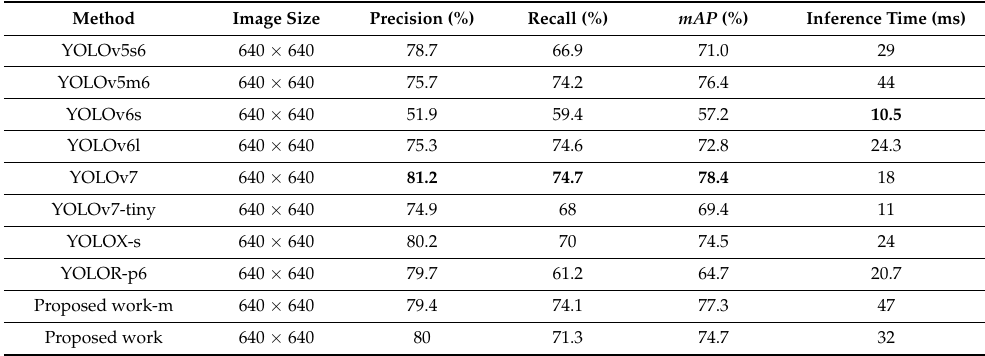
Table 4. Accuracy comparison between YOLO series and proposed work.